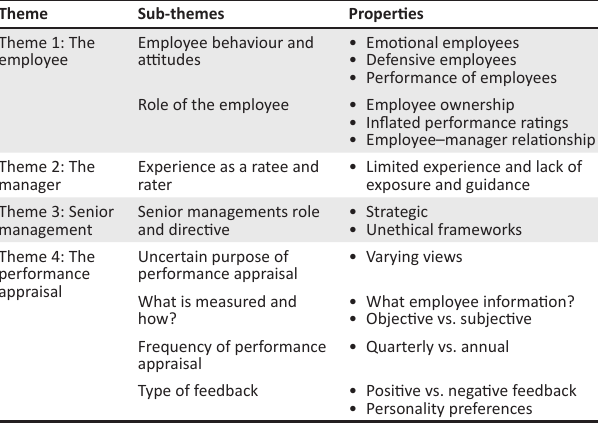
TABLE 1: Grouping findings into main themes and